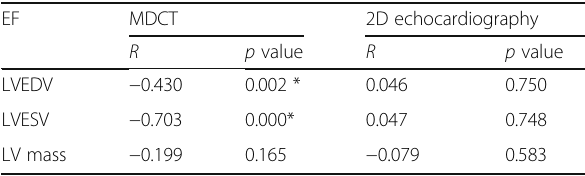
Table 3 Correlation between ejection fraction, LVEDV, LVESV, and LV mass measured by MDCT and 2D echocardiography EF MDCT 2D echocardiography R p value R p